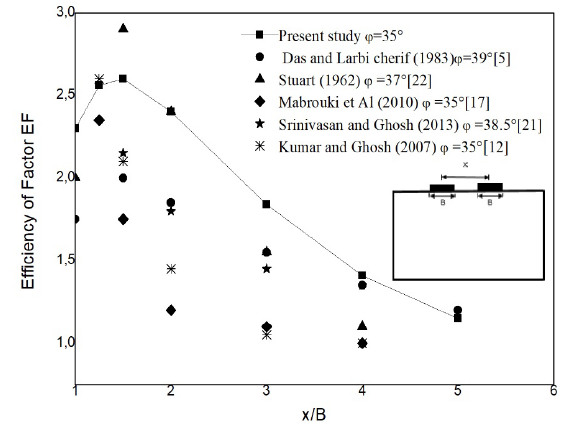
Figure 8: Comparison of EF values of strip footing without cavities with values reported in literature.